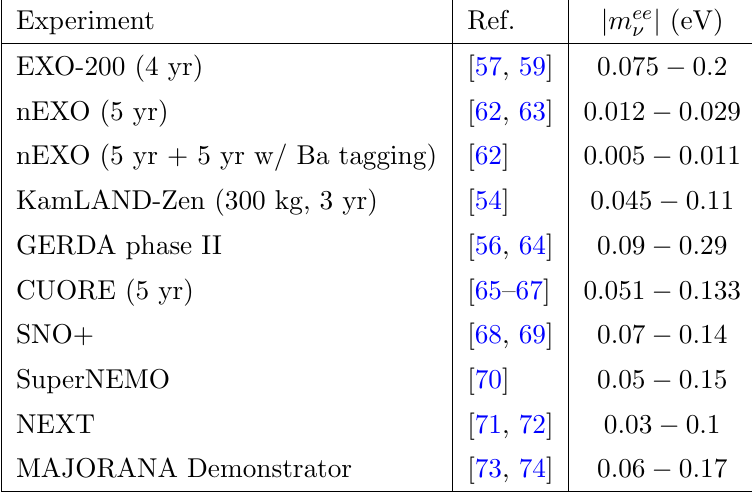
Table 1 . Sensitivity of several 0 (cid:23) 2 (cid:12)